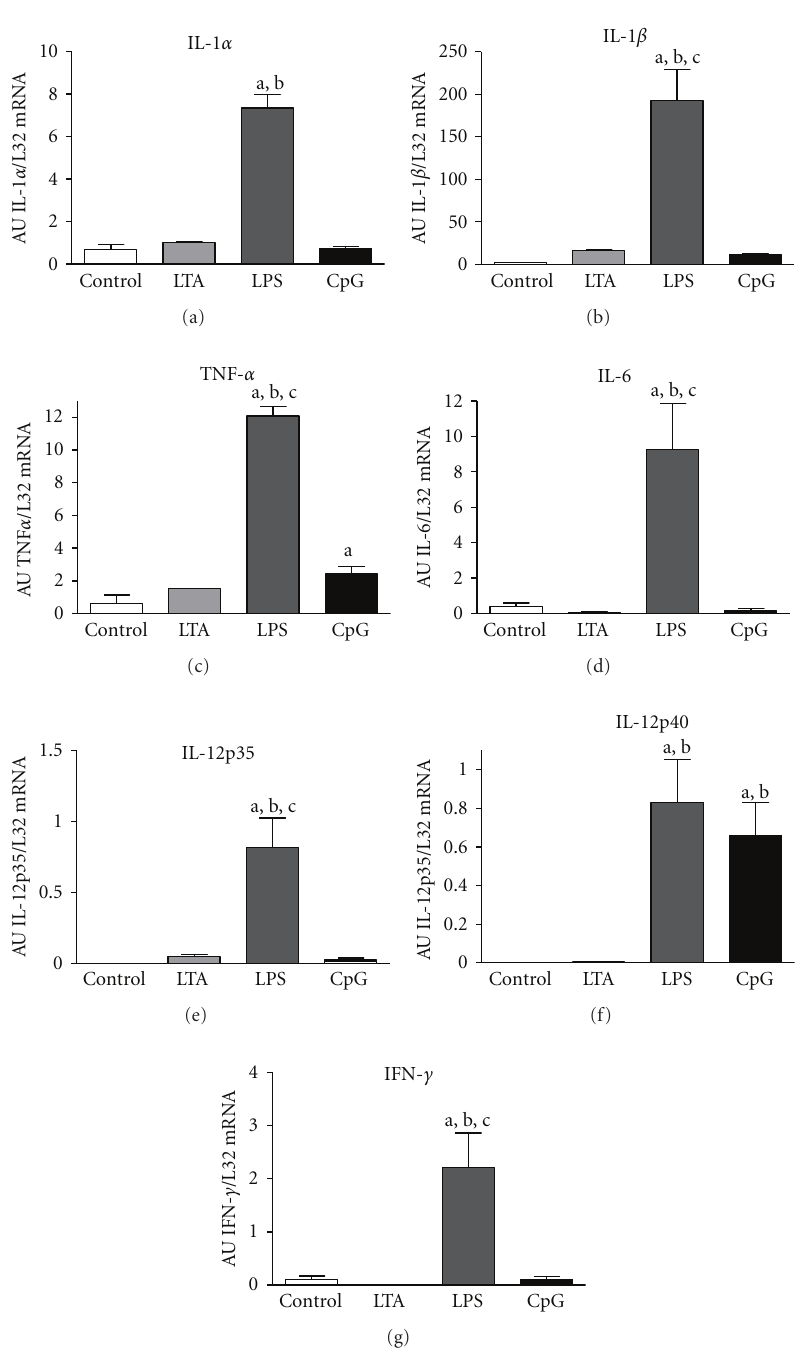
Figure 3: Cytokine mRNA expression. Densitometric analysis of IL-1 α , IL-1 β , TNF- α , IL-6, IL-12p35, IL-12p40, and IFN- γ in control, LTA-, LPS-, and CpG-ODN-stimulated pulmonary tissue. Values of mRNA expressions are normalized to L32 and expressed as arbitrary units (AU). Alphabetic characters indicate P -values < . 05 from Bonferroni post hoc testing (a = versus control, b = versus LTA, c = versus CpG-ODN; n = 4; M ± SEM; n =